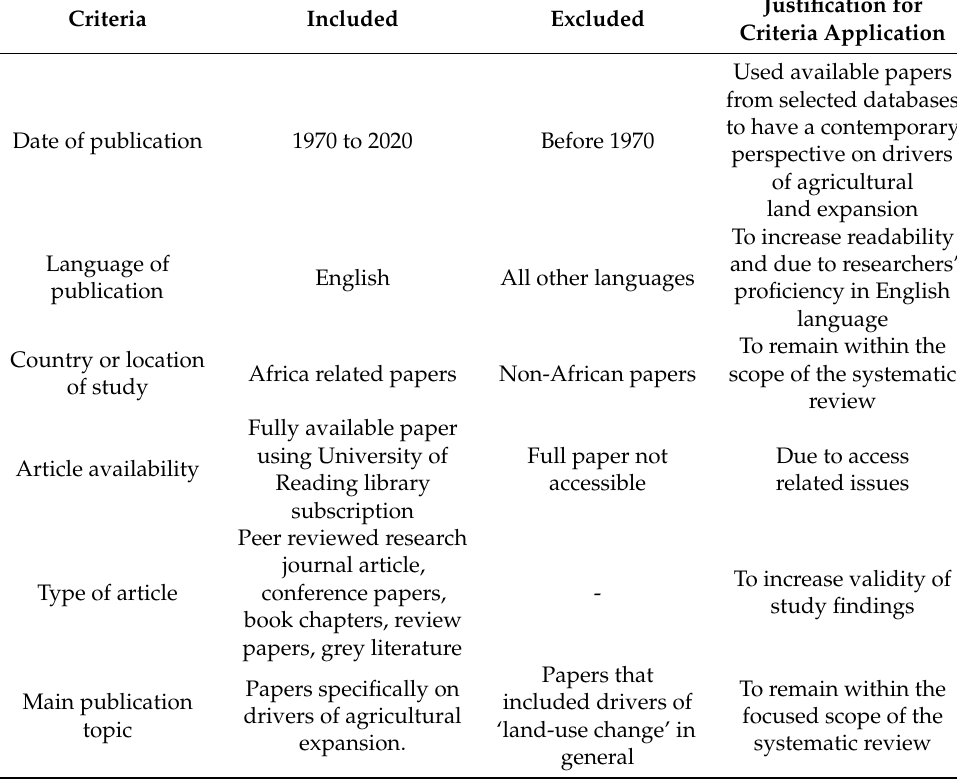
Table 1. Inclusion and exclusion criteria for the review articles in the order of selection.